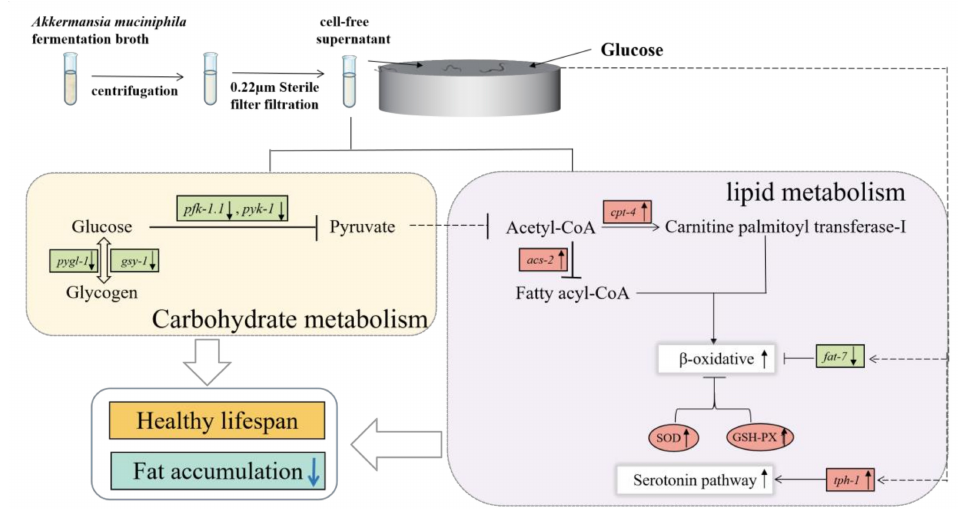
Figure 6. Molecular mechanisms by which A. muciniphila cell-free supernatant improves glucol- ipid metabolism in C. elegans . “ ↑ ” in boxes represent upregulation, and “ ↓ ” in boxes represent downregulation. Other are connecting